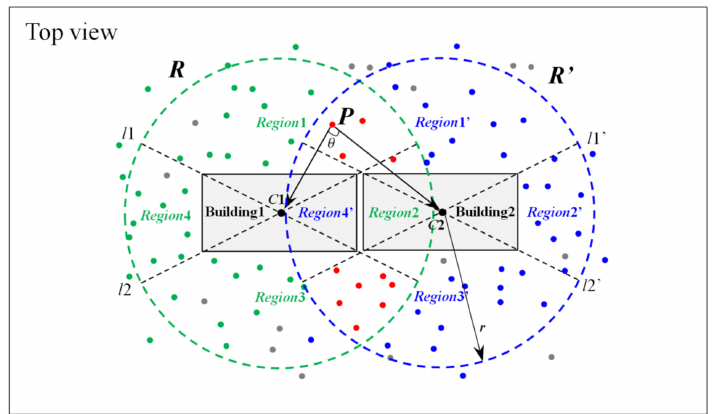
Figure 3. Relevant public-image collection. C 1 and C 2 are the centers of Buildings 1 and 2, respectively. R and R ’ are the regions corresponding to Buildings 1 and 2, respectively. ( l 1, l 2) and ( l 1 (cid:48) , l 2 (cid:48) ) are the splitting lines of R and R ’, respectively. Region 1-4 and Region 1 (cid:48) -4 (cid:48) are the subregions split by ( l 1, l 2) and ( l 1 (cid:48) , l 2 (cid:48) ), respectively. Green and blue dots denote the terrestrial images that may be related to Buildings 1 and 2 within the radius, r , respectively. Red dots denote the public images that may be related to buildings (i.e., Building 1 and 2), and gray dots denote the terrestrial images that are unrelated to either Building 1 or 2. θ is the angle between two vectors,